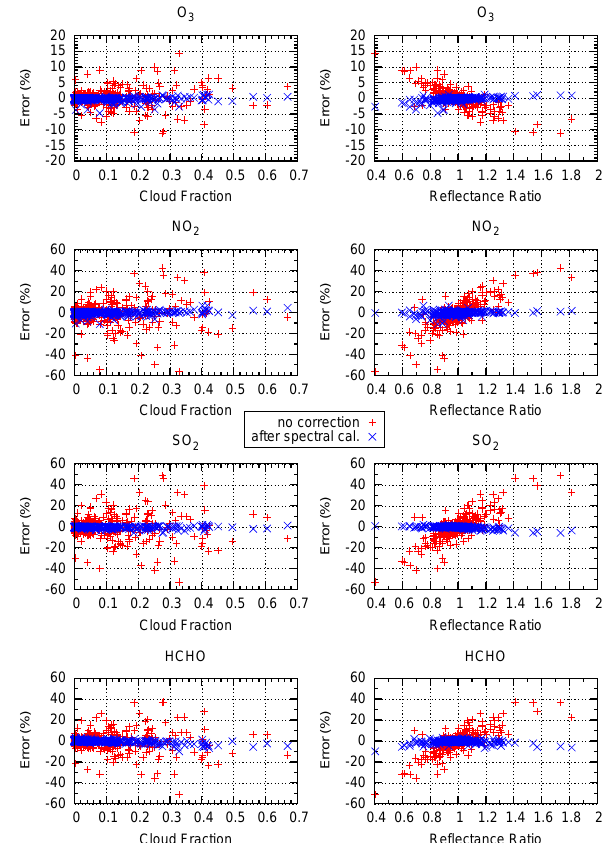
Fig. 6. Tropospheric column errors as function of cloud fraction (left panels) and reflectance ratio (right panels) without (red) and with (blue) spectral